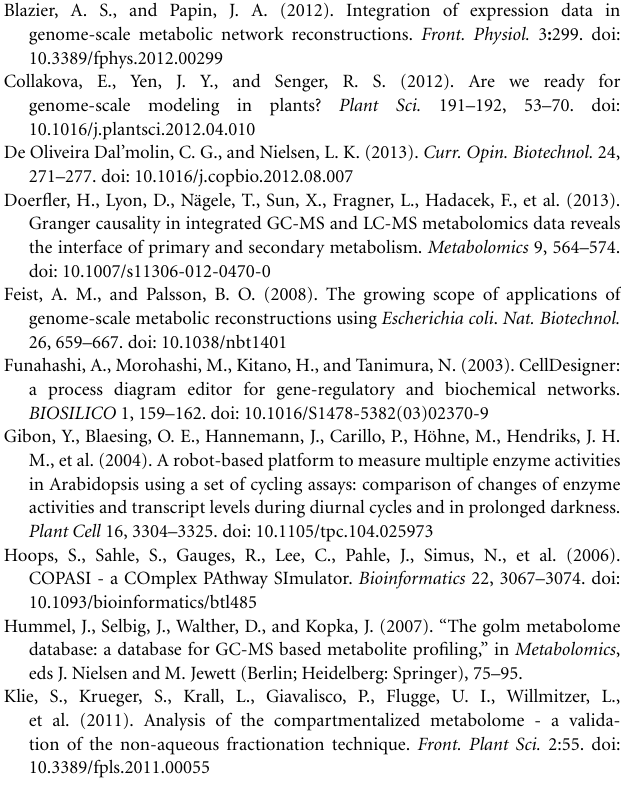
Figure S1 | Schematic overview of the model reduction process. In contrast to metabolite (B) , metabolites (A) and (C) are accessible by a GC-MS measurement and are kept in the reduced model structure. Table S2 | Reactions included in the reduced model (column B) are compared to reactions of the original reconstruction network (column E). Reactions which have been identified to be affected differentially during cold exposure of sensitive and tolerant Arabidopsis accessions are marked in yellow (referring to Figure 1